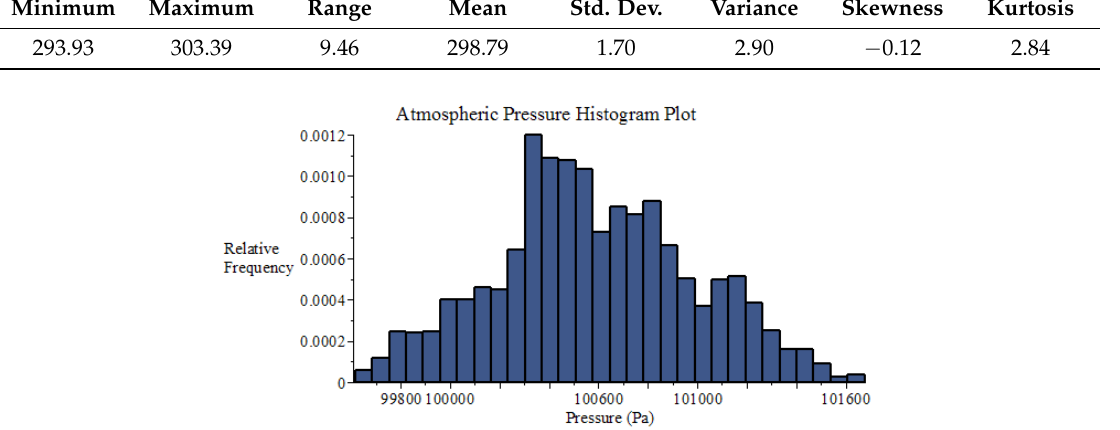
Figure B3. Histogram plot of inlet water temperature data collected by SRNL from F-Area cooling towers (unsaturated conditions). Table B6. Statistics of the inlet water temperature distribution [K].